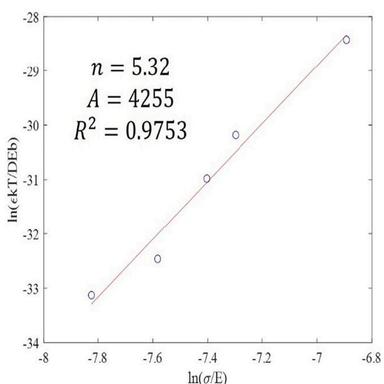
Bird-Mukherjee-Dorn plot to determine dominant creep mechanism.